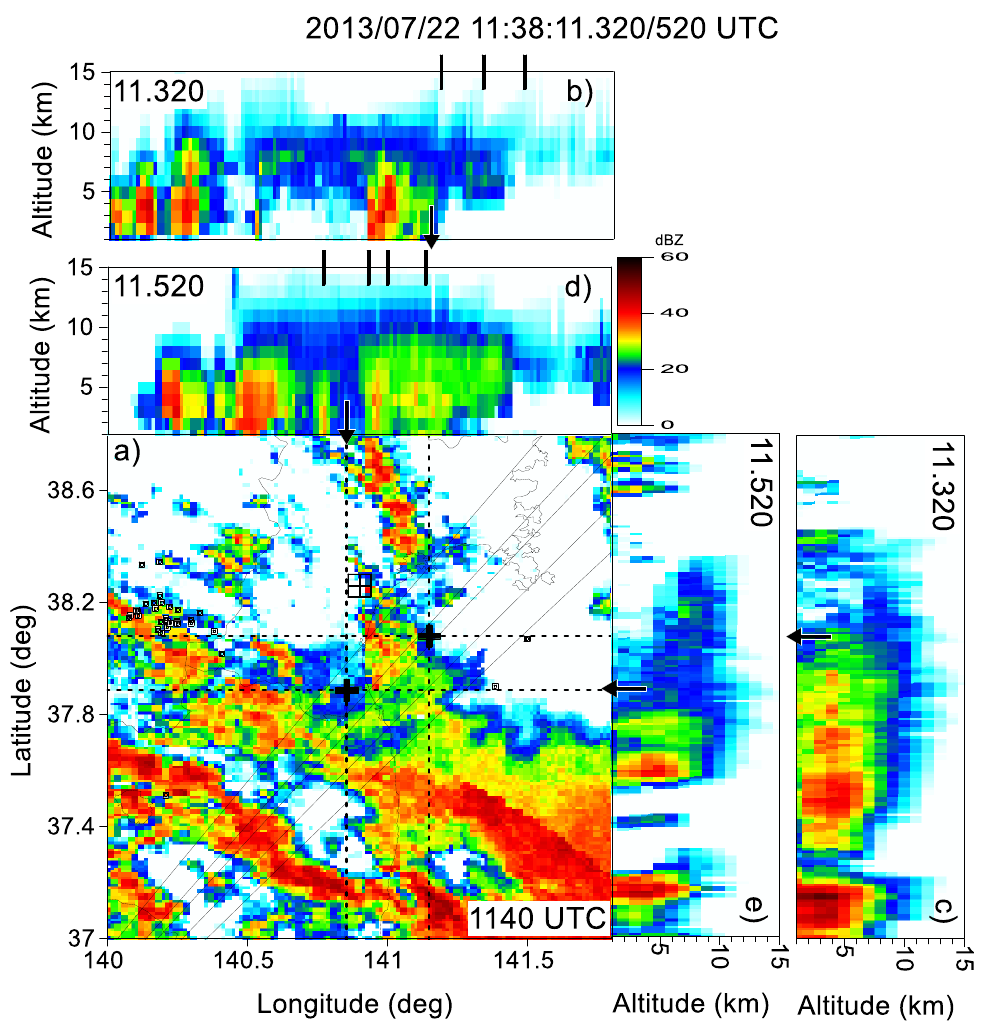
Figure 8. The horizontal and vertical cross-sections of the parent MCS with respect to the third and fourth sprites at 1138:11.320 and 1138:11.520 UTC. The descriptions ( a – e ) are the same as in Figure 6.